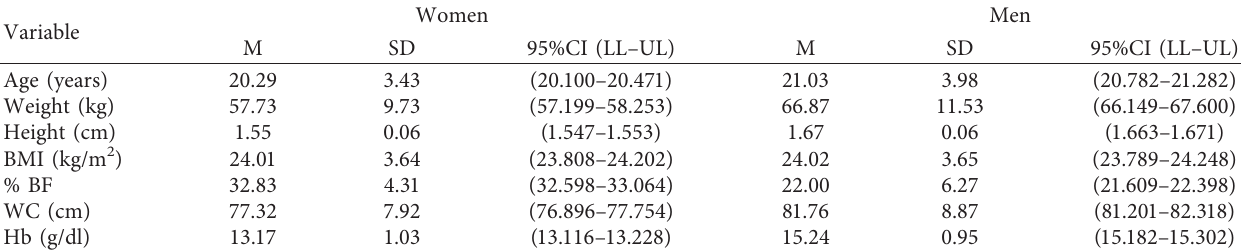
Table 2: Anthropometric parameters and hemoglobin in university students.